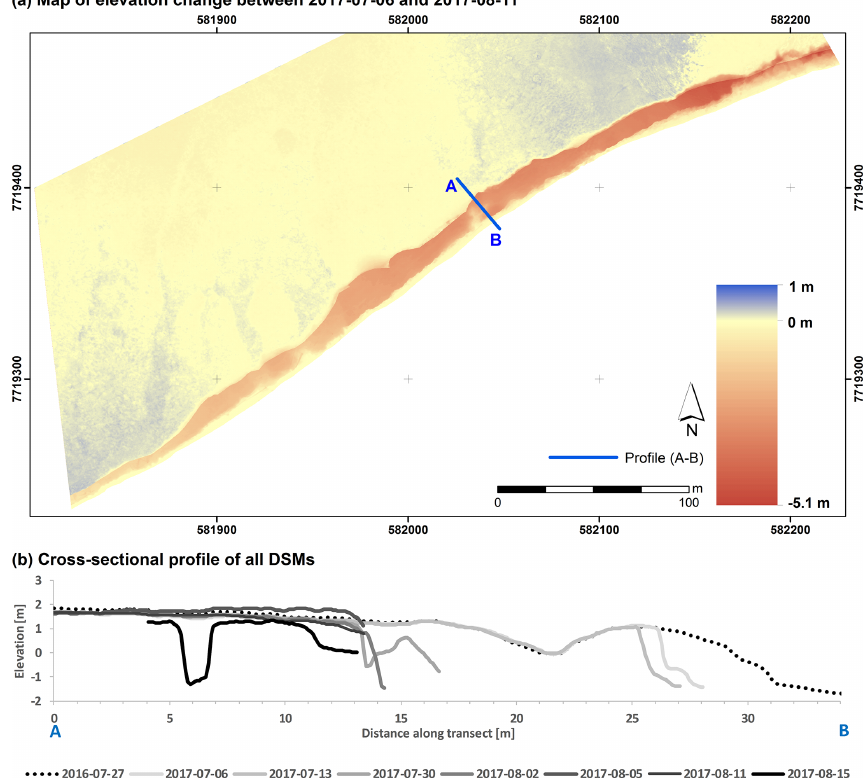
Figure 4. (a) Map of elevation change in digital surface models between 6 July and 11 August 2017, illustrating areas of erosion along the coastline with up to − 5 . 1m of change and also some minor (ca. 0.1m) increases inland that we attribute to vegetation development. (b) Elevation profiles along the A–B transect shown in (a) and Fig. 3, extracted from digital surface models (no vertical exaggeration). Note that two of the latter elevation models (from 8 and 15 August 2017) both suffered from datum problems due to insufficient spatial constraint; see discussion for